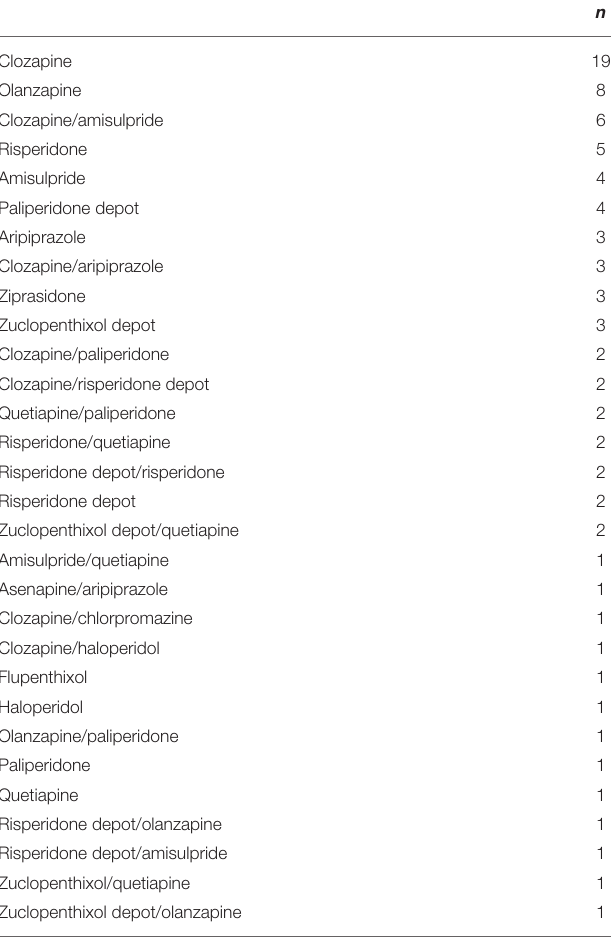
TABLE 6 | Antipsychotic medication breakdown in the chronically ill patients with schizophrenia.